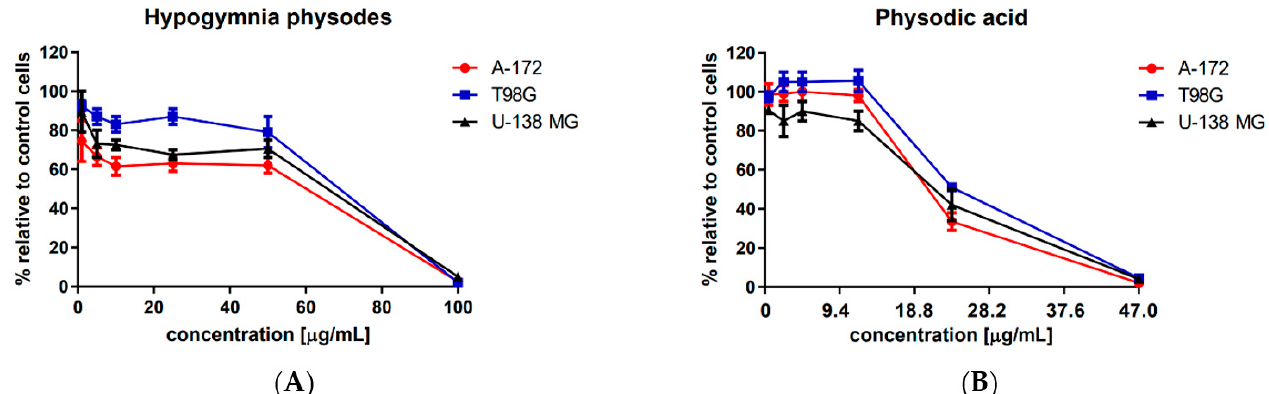
Figure 2. The effect of Hypogymnia physodes extract ( A ) and physodic acid ( B ) on the viability of A-172, T98G and U-138 MG cell lines. The mean values ± SEM from three independent experiments with four measurements per assay are presented. Table 1. The IC 50 of cells viability after Hypogymnia physodes extract or physodic acid exposition.